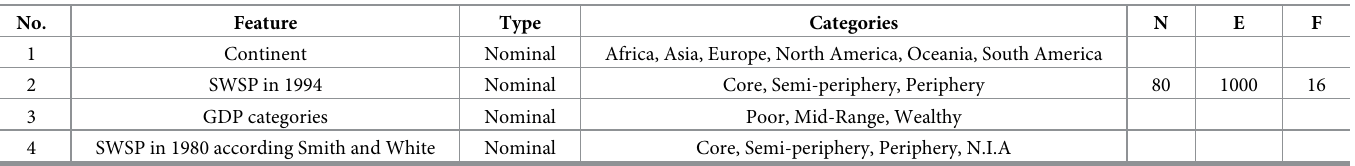
SWSP stands for Structural World System Position; GDP, for Gross Domestic Product per capita. Symbols N, E, and F show the number of nodes, the number of edges, and the number of node features, respectively.